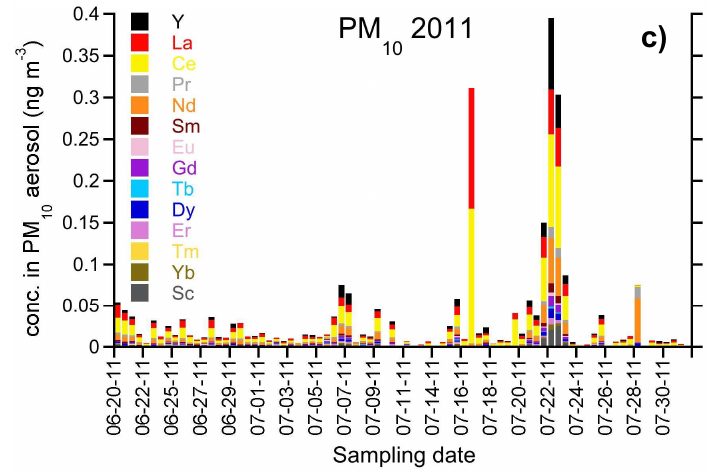
Figure 17. Stack column plots showing the concentration versus time profiles for trace metal concentrations measured in PM 10 aerosol during the AREX 2011 cruise. In order to differentiate the value distribution of all the metals, the determined parameters were classified as “major trace” ( a ), “minor trace” ( b ), and “REEs” ( c ).